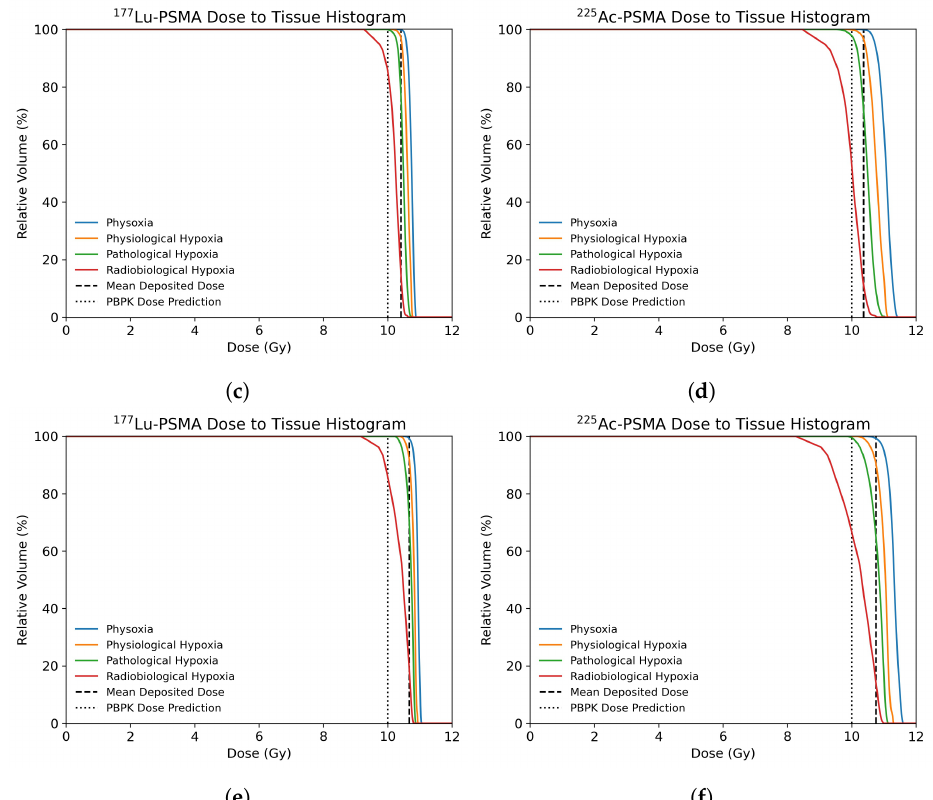
Figure 3. ( a , c , e ) Cumulative dose to tissue histogram of deposited dose in ROI A, ROI B and ROI C, respectively, within each tissue segment with 177 Lu-PSMA treatment at twenty days post-injection. ( b , d , f ) Cumulative dose to tissue histogram of deposited dose in ROI A, ROI B and ROI C, respectively, within each tissue segment with 225 Ac-PSMA treatment at twenty days post-injection.